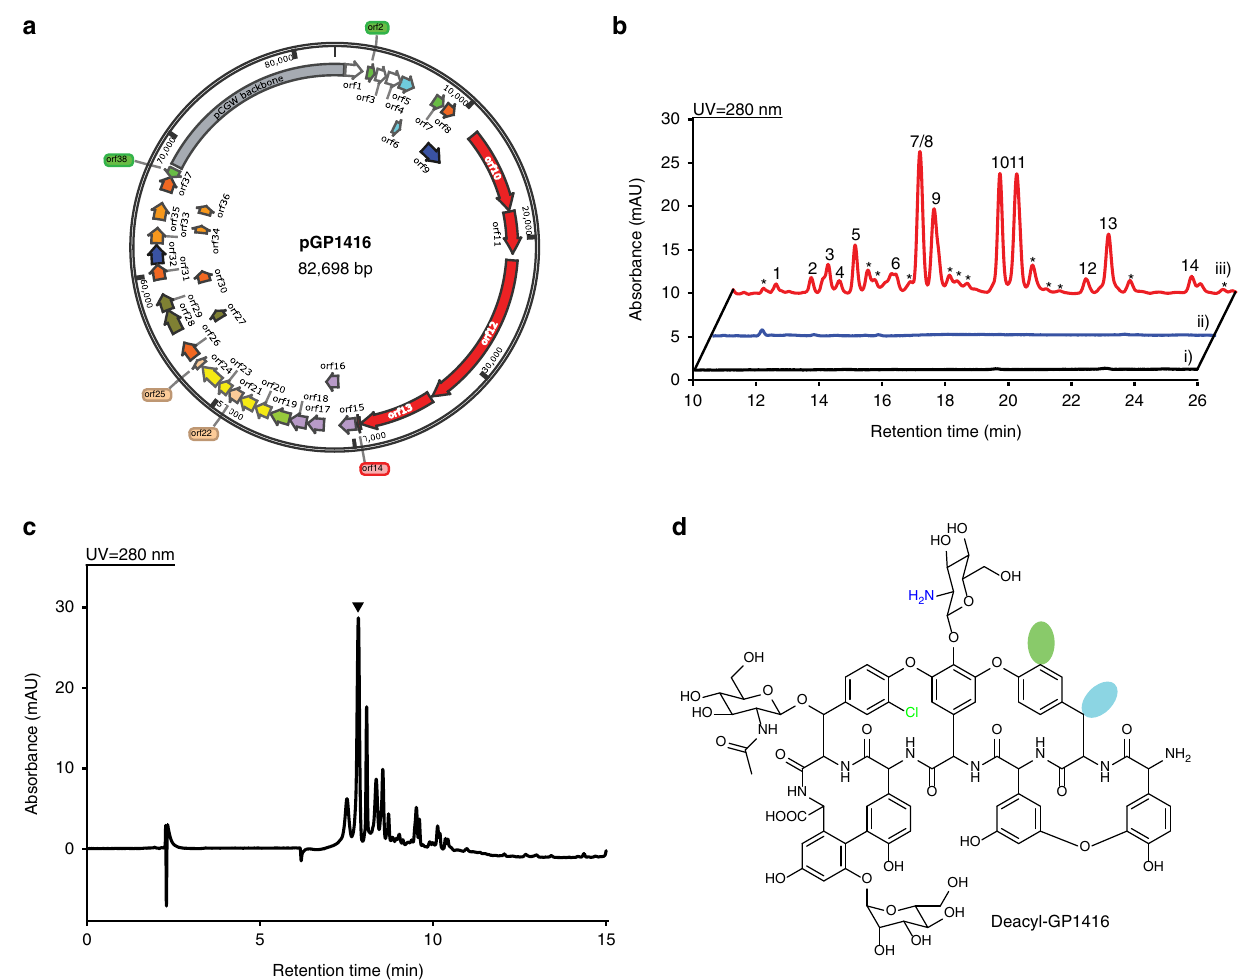
Fig. 3 Discovery of the cryptic GP1416 from Amycolatopsis sp. WAC01416 using GPAHex. a pGP1416 bearing GP1416 BGC captured through TAR. b Heterologous expression of GP1416 using GPAHex. GP1416 analogs can only be detected in the GPAHex host (iii)) but not in the parental strain Amycolatopsis sp. WAC01416 (i)) or in S. coelicolor M1154/pGP1416 (ii)). Peaks 1 – 14 are labeled and their associated MS spectra and proposed structures are presented in Supplementary Fig. 12. Peaks labeled with asterisks are also GP1416 analogs showing characteristic UV absorption of GPA. c Heterologous expression of deacyl-GP1416 using GPAHex. Acyltransferase deletion mutant S. coelicolor M1154/pAMX4/pGP1416 Δ orf22 shows less complex GPA production (compare to trace iii) in ( b ). Deacyl-GP1416 labeled with inverted triangle is puri fi ed and characterized as shown in ( d ). d Chemical structure of deacyl-GP1416. Peptide scaffold of GP1416 varies by the presence of a Tyr, Bht, m-Cl-Tyr, or m-Cl-Bht residue at position AA2 and a Bht or m-Cl-Bht residue at position AA6. Putative chlorination (green) and hydroxylation (cyan) on AA2 are